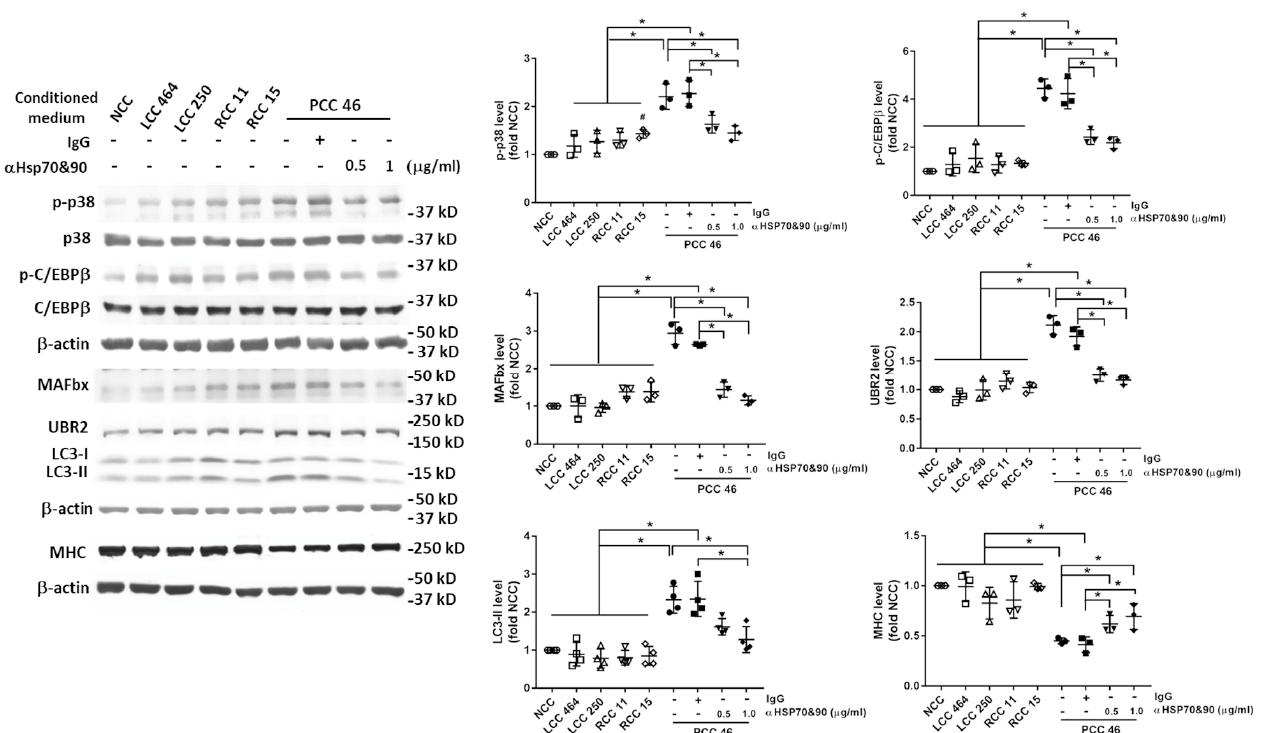
Figure 3. PCC activates p38 β MAPK-mediated catabolic pathways in myotubes by releasing Hsp70